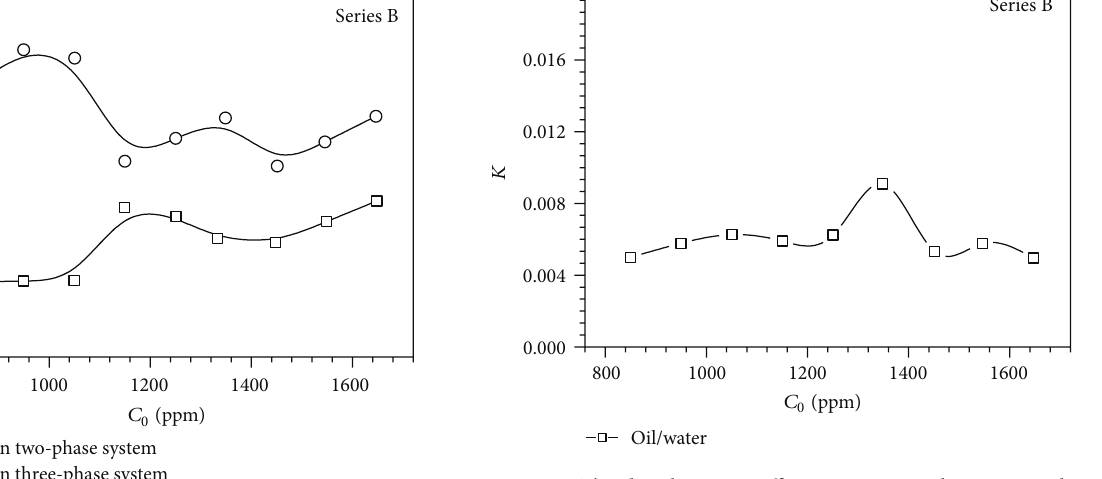
Figure 6: The distribution coefficient in water- sands system in the two-phase and three-phase systems in the simulative water B.